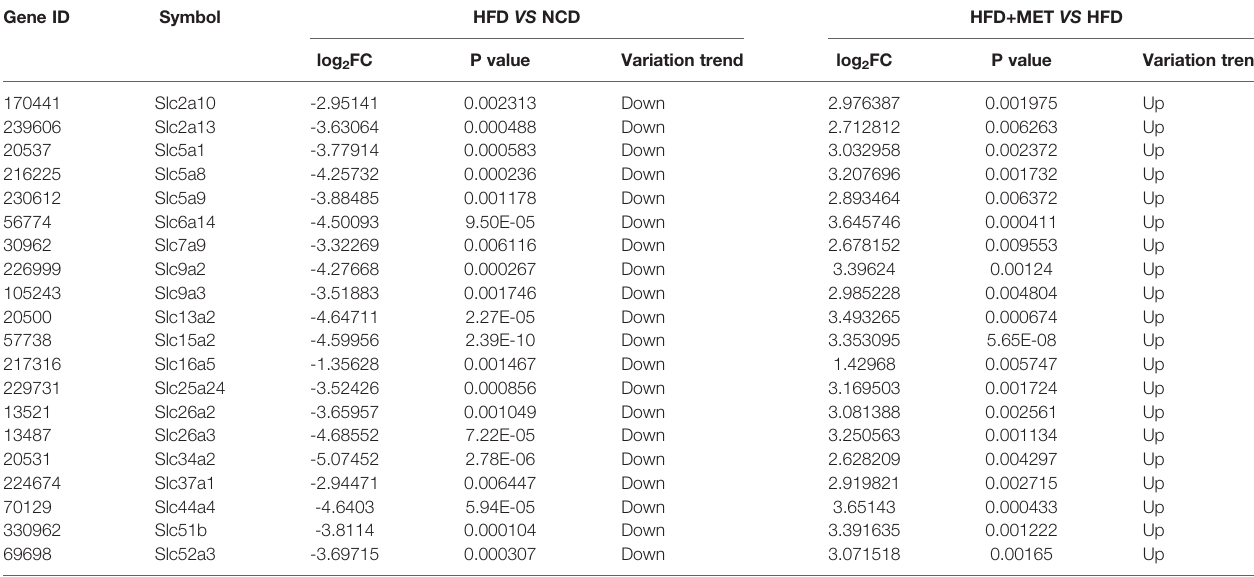
TABLE 3 | MET-responsive Slc transporters DEGs in liver (\log2FC\ ≥ 1 and P<0.01). Gene